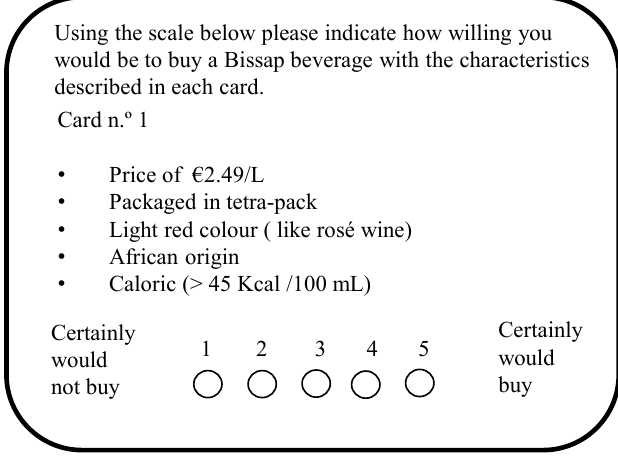
Figure 1. Example of a Bissap profile used for evaluation in the conjoint questionnaire.